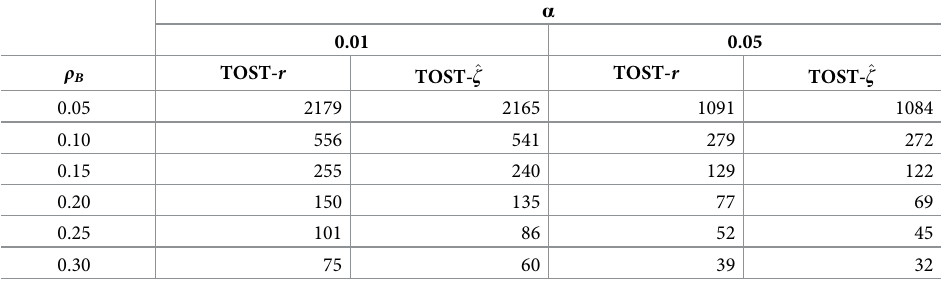
region TOST- ^ z shares the same disadvantage as TOST- r . The last quantity in Eq 22 indicates that the Type I error rate of the TOST- ^ z procedure usually does not attain the nominal level α . However, the Type I error rate of the TOST- ^ z method also has the supremum α as the other TOST- r method when the sample size goes to infinity. For finite sample sizes, the rejection region becomes invalid when ^ z tion region TOST- ^ z is empty if N < 1083.4132 when ρ 0.10. The minimum sample sizes for a nonempty rejection region TOST- ^ z are also listed in Table 2 for α = 0.01 and 0.05, and ρ